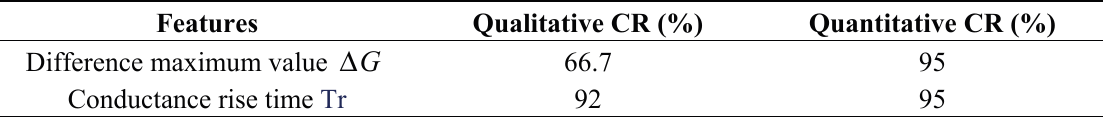
Table 2. Classification rates (CR) of different features in